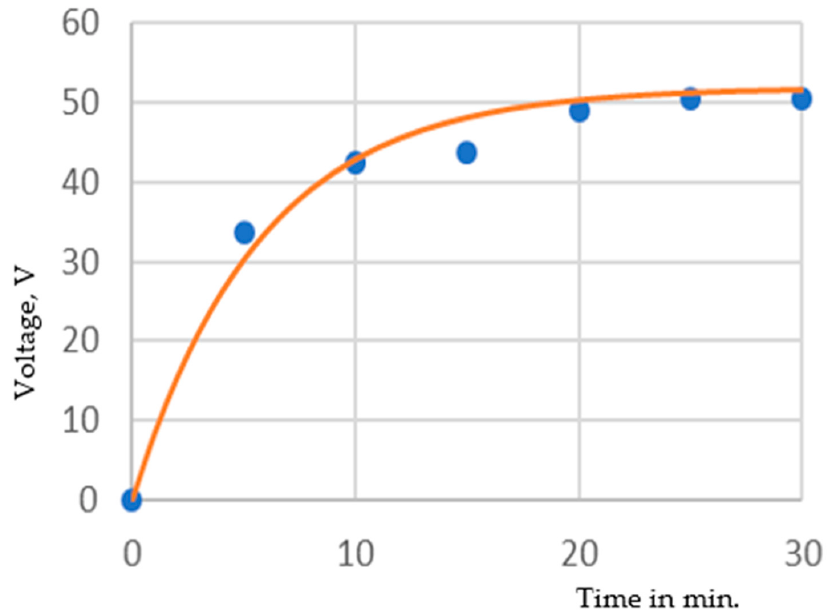
Figure 9. Measured voltage buildup in C 0 for a distance of 60 cm between the metal plate 2 and the live power cable.